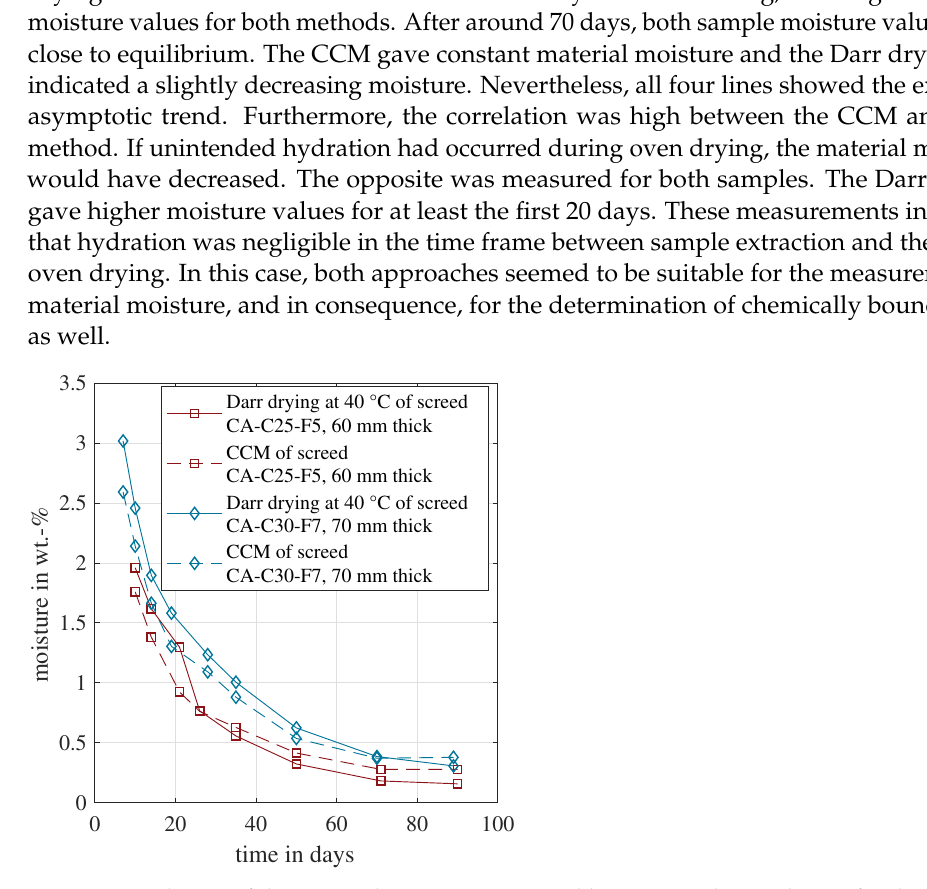
Figure 3. Evolution of the material moisture measured by CCM and Darr drying for the calcium- sulphate-based samples CA-C25-F5 and